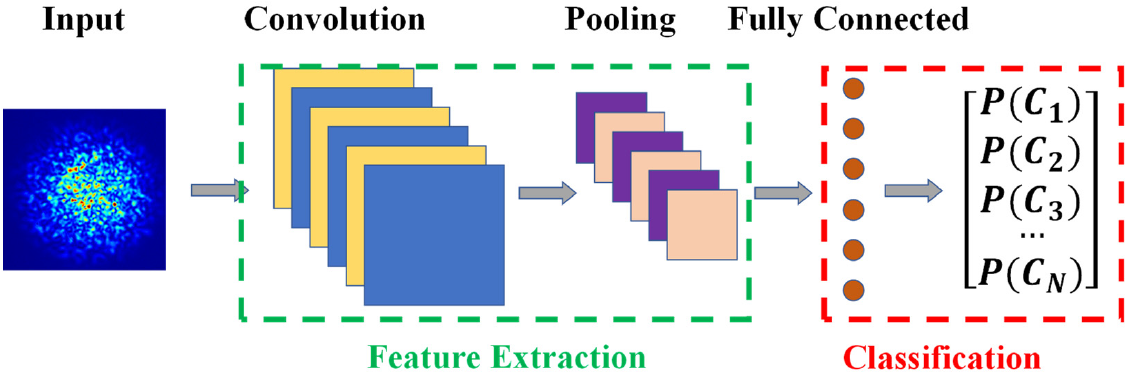
Figure 1. The architecture of classification neural network based on CNN.